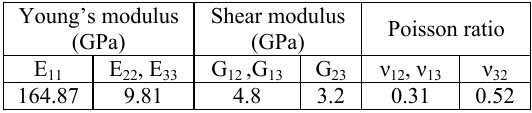
Table 2. Mechanical properties of IM7/8552 carbon/epoxy